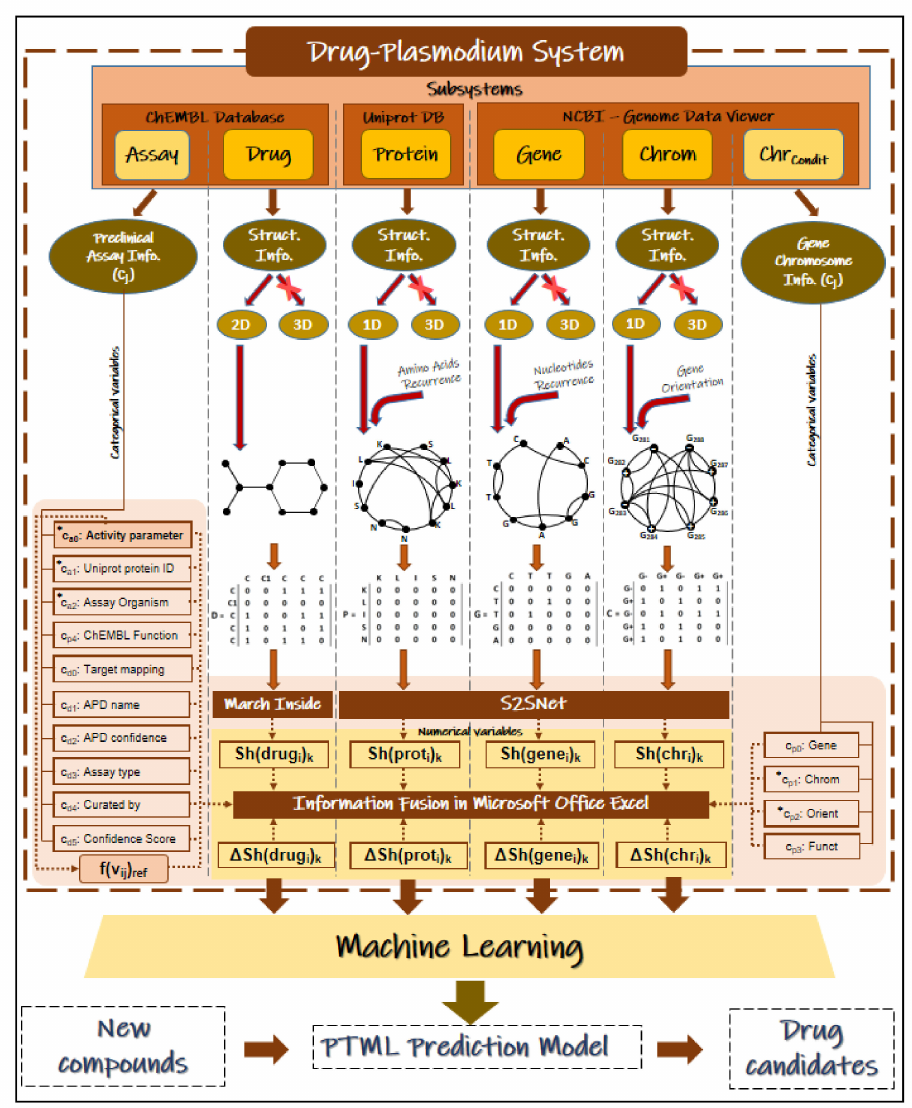
Figure 6. IFPTML model development and IF